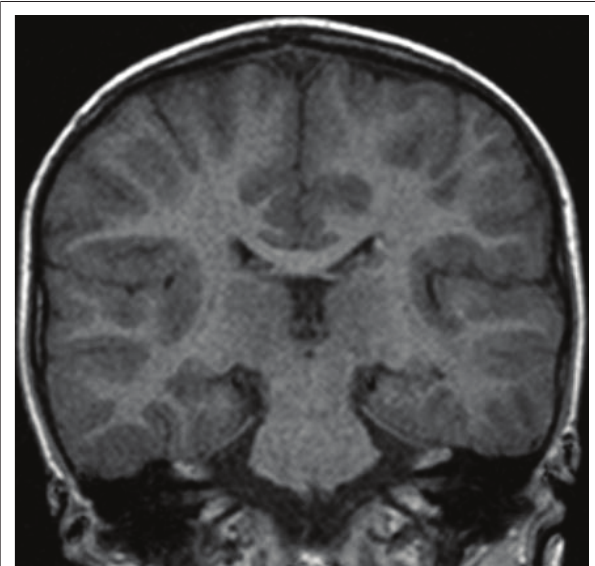
FIGURE 5: Coronal T1-weighted MR image.